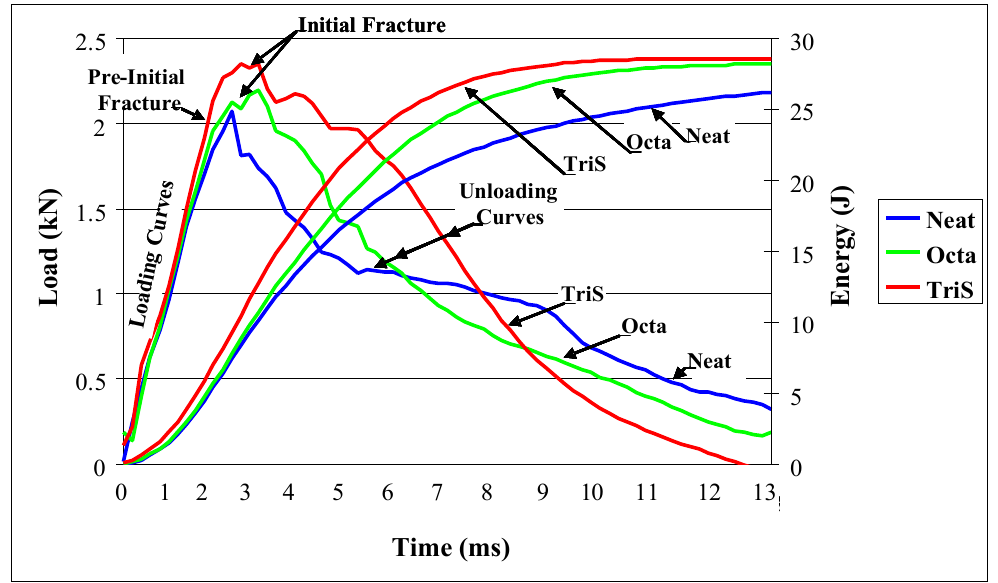
Figure 3. Low velocity impact testing